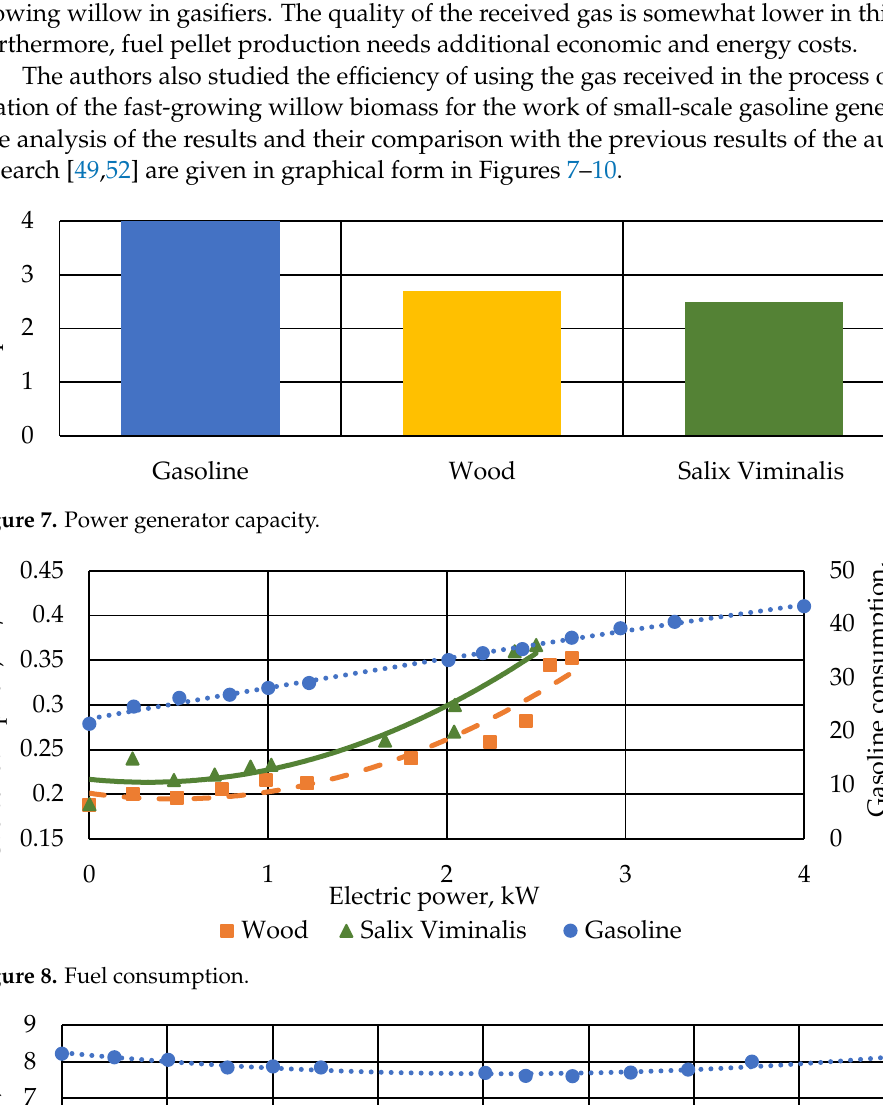
Figure 8. Fuel consumption.